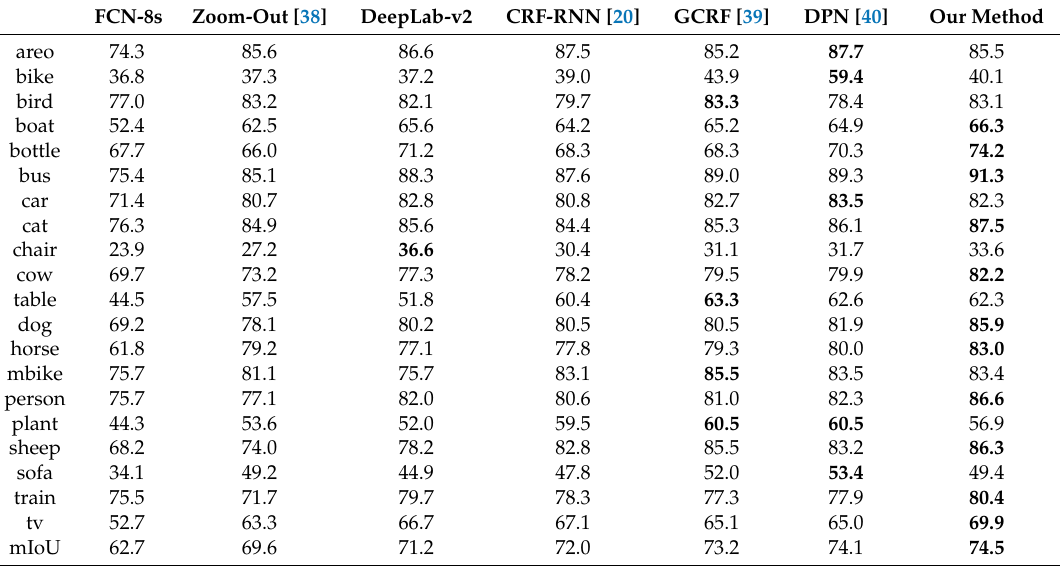
Table 2. Per-class IoU score on VOC dataset. Best performance of each category is highlighted in bold.